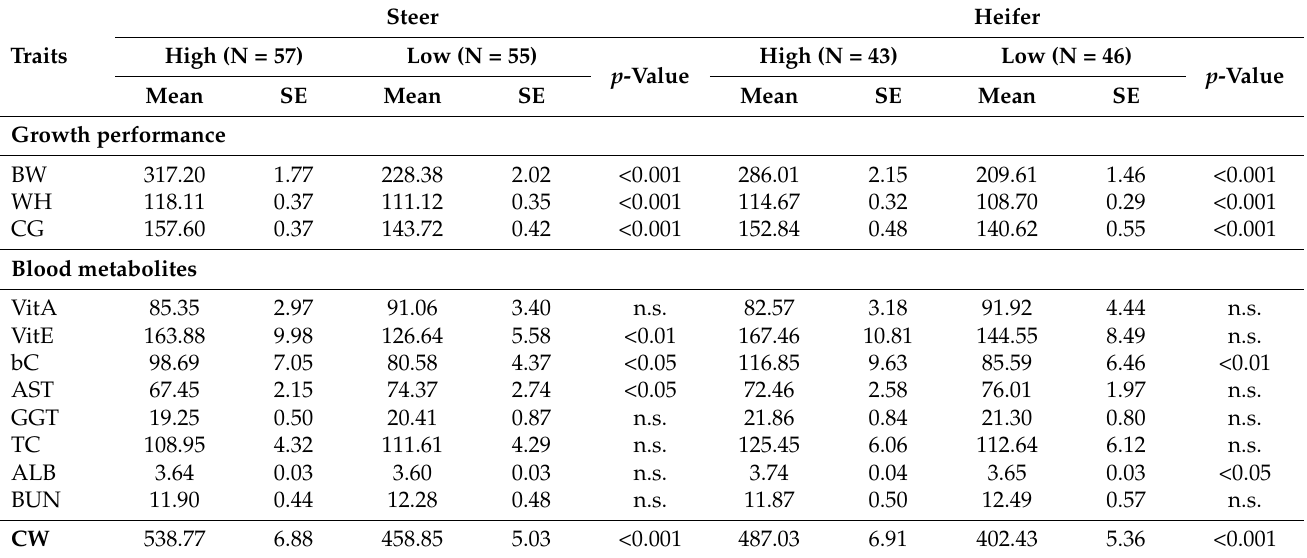
Table 4. Comparisons of growth performance, blood metabolites, and carcass weight between high and low body weight (BW) groups. Growth performance and blood metabolites were measured at the start of fattening (approximately 8–10 months). SE: Standard error. Abbreviations of traits are shown in Table